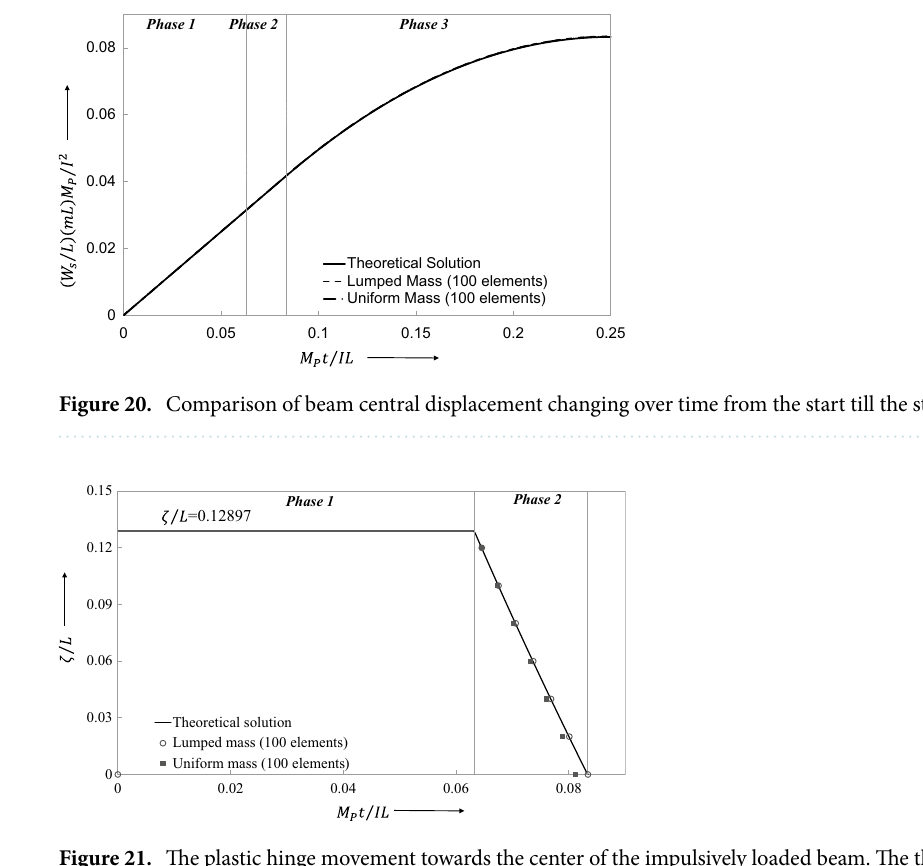
Figure 21. The plastic hinge movement towards the center of the impulsively loaded beam. The theoretical and LCP analysis is